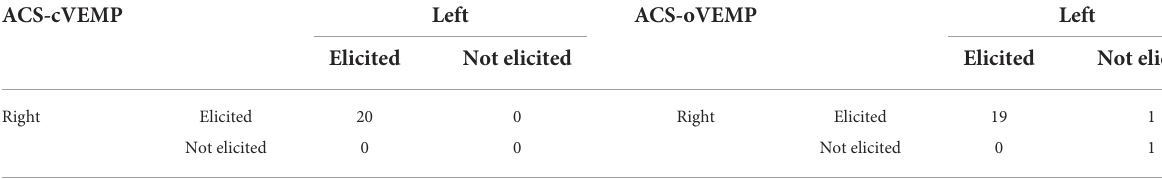
TABLE 2 Response rates of ACS-cVEMP and ACS-oVEMP.